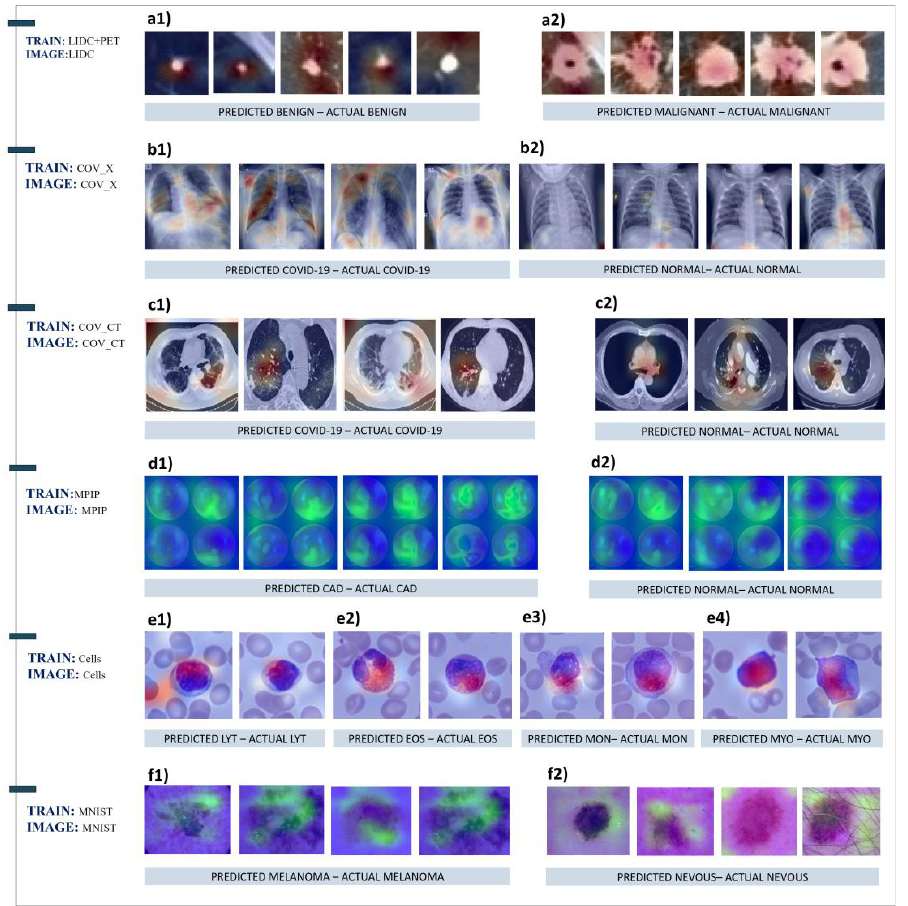
Figure 7. Grad-CAM results for the following test dataset samples: ( a ) LIDC, ( b ) COV_X, ( c ) COV_CT, ( d ) MPIP, ( e ) Cells, and ( f ) MNIST.